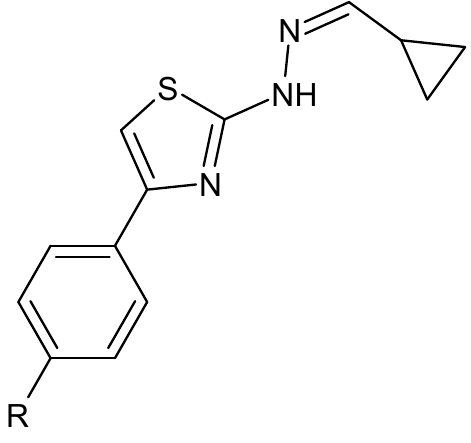
Ł ˛aczkowski et al. presented synthesis and investigation of antifungal, anticonvulsant and anti- Toxoplasma gondii activities of ten novel (2-cyclopropylmethylidene)hydrazinyl)- thiazole derivatives (Figure 16). Some of them, with fluoro, cyano and nitro group in position para of the phenyl ring, showed significant anti- Toxoplasma gondii activity, with IC 50 values 31–52 times lower than those observed for sulfadiazine. The results of the cytotoxicity evaluation and anti- Toxoplasma gondii activity studies showed that Toxoplasma gondii growth was inhibited at non-cytotoxic concentrations for the mouse L929 fibroblast and the African green monkey kidney (Vero) cells [82].